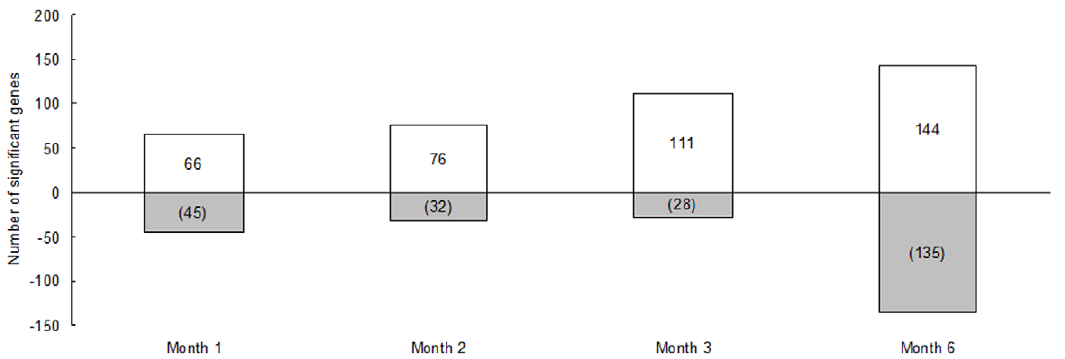
Figure 1. Distribution of genes influenced by E.multilocularis infection according to the time of infection. The number of genes significantly up- (positive values) and down-regulated (negative values) is shown at each time point.